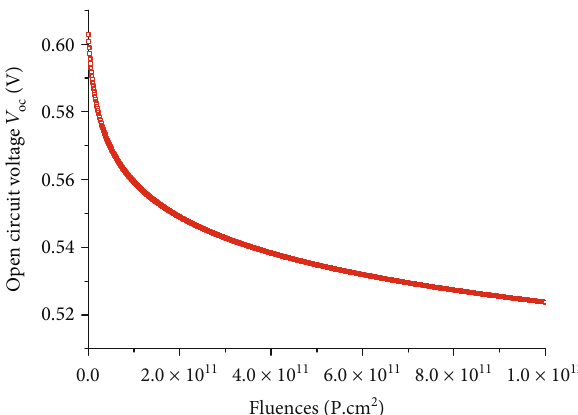
Figure 5: Open-circuit voltage versus fl uence ( L 4 : 10 4 cm : s − 1 ; Sf = 0cm : s − 1 ; D 5 : 6 : 10 − 7 ).